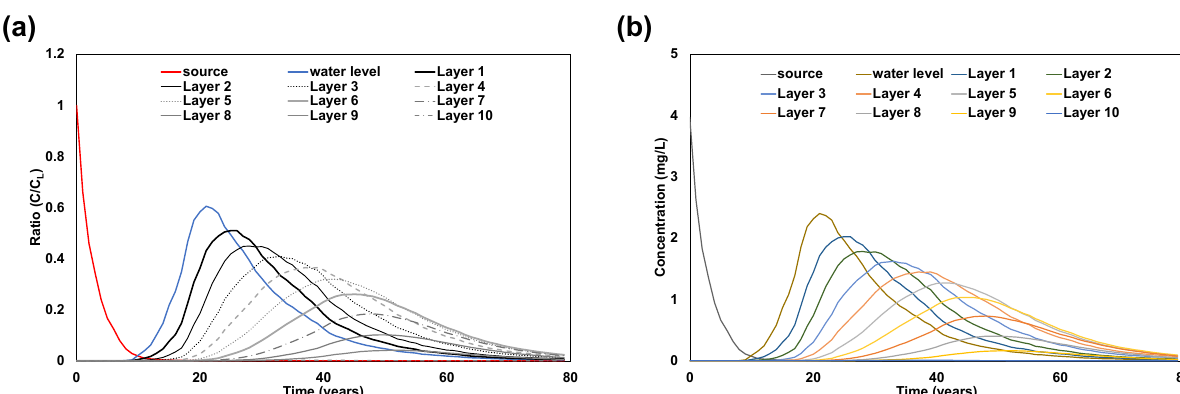
Figure 10. Temporal profile of source depletion, breakthrough curves (BTCs) at groundwater level, and exposure concentration (L = 5 m, D = 1 m) expressed in ( a ) relative concentration compared to leaching concentration from source and ( b ) concentration for 1 mg/kg of initial source mass considered.